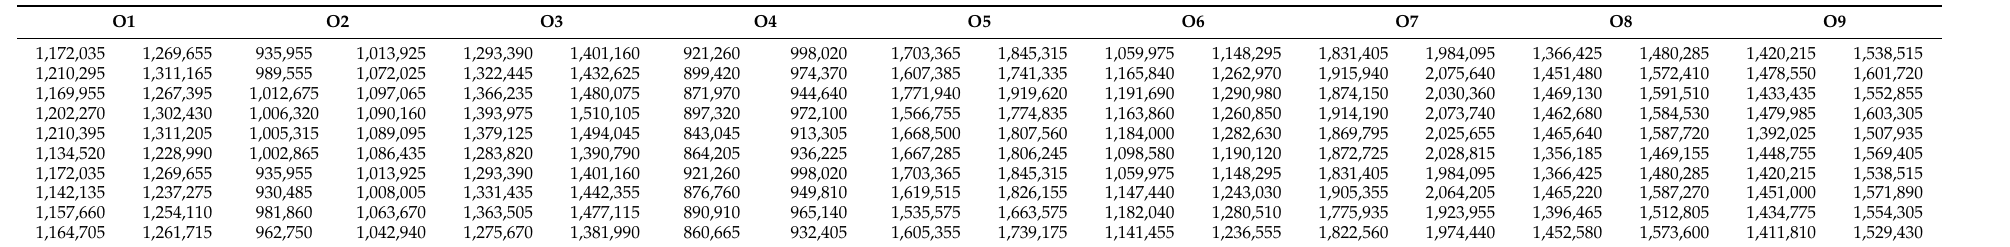
Table 5. Best compromise solution for each DM (the i -th row corresponds to the i -th